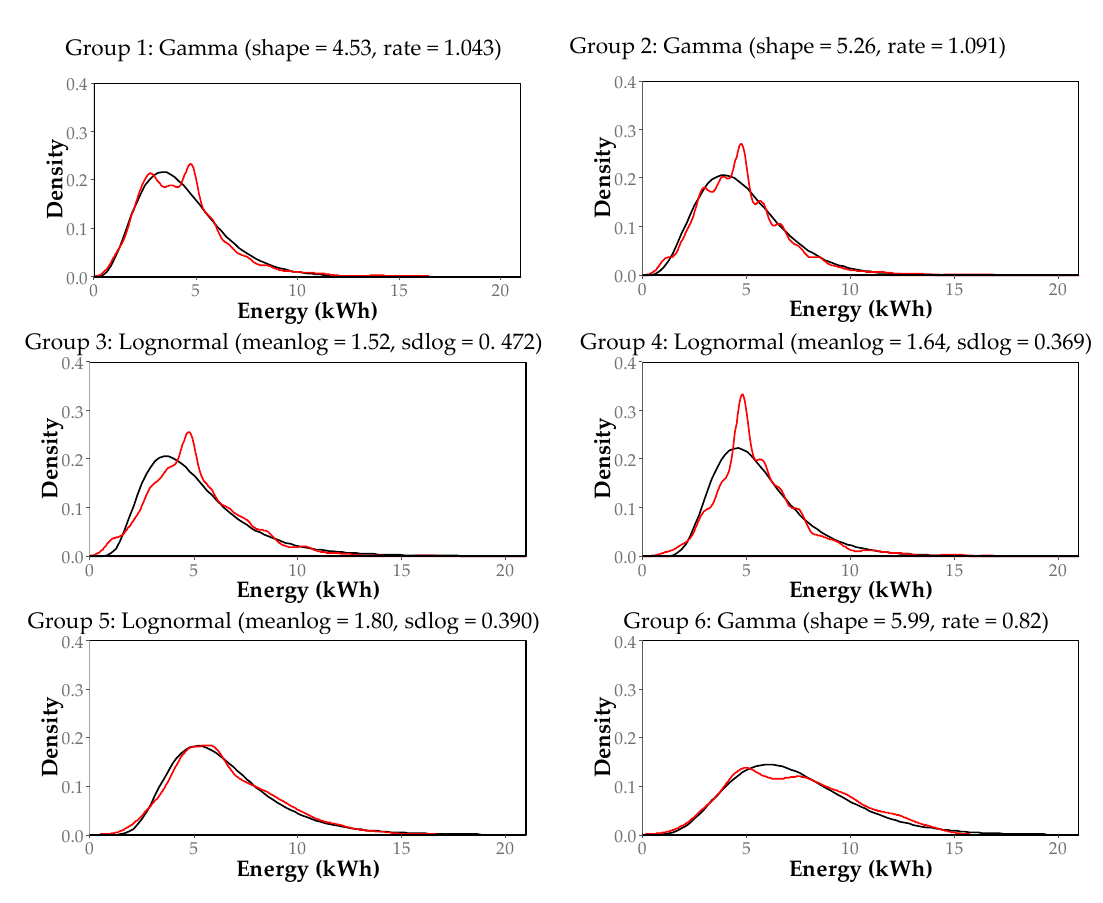
Figure 3. Charge density distributions per group of hours.